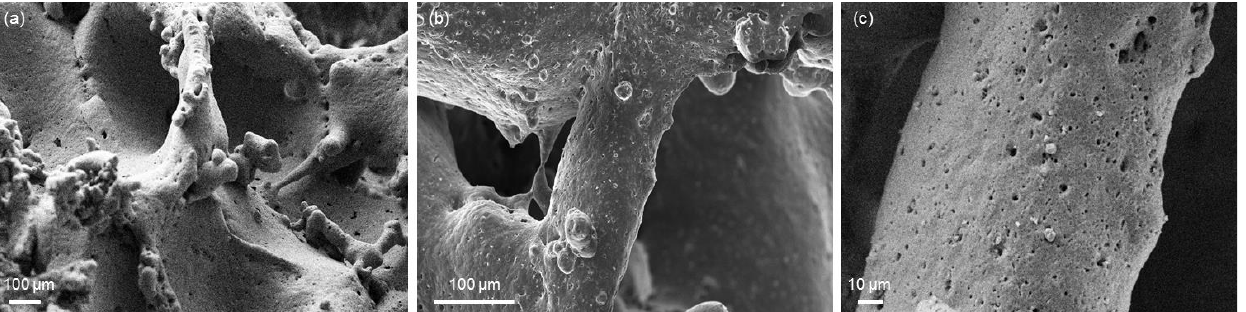
Figure 4. Investigation of 1d-derived scaffold morphology: ( a ) 3D pore–strut architecture, ( b ) sintered strut, and ( c ) details of the surface of the strut. The total porosity of 1d-derived scaffolds (68 ± 10 vol %) is comparable to that of human healthy cancellous bone (50–80 vol % [39,40]) and falls into the optimal range recommended for tissue engineering scaffolds